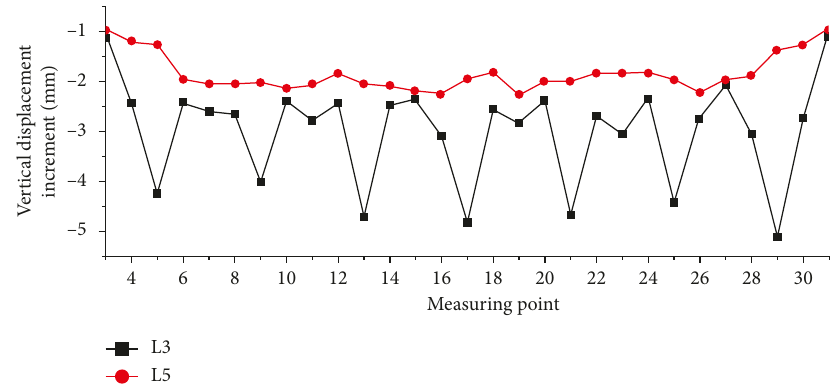
Figure 11: Observation results of vertical displacement of line L3 and line